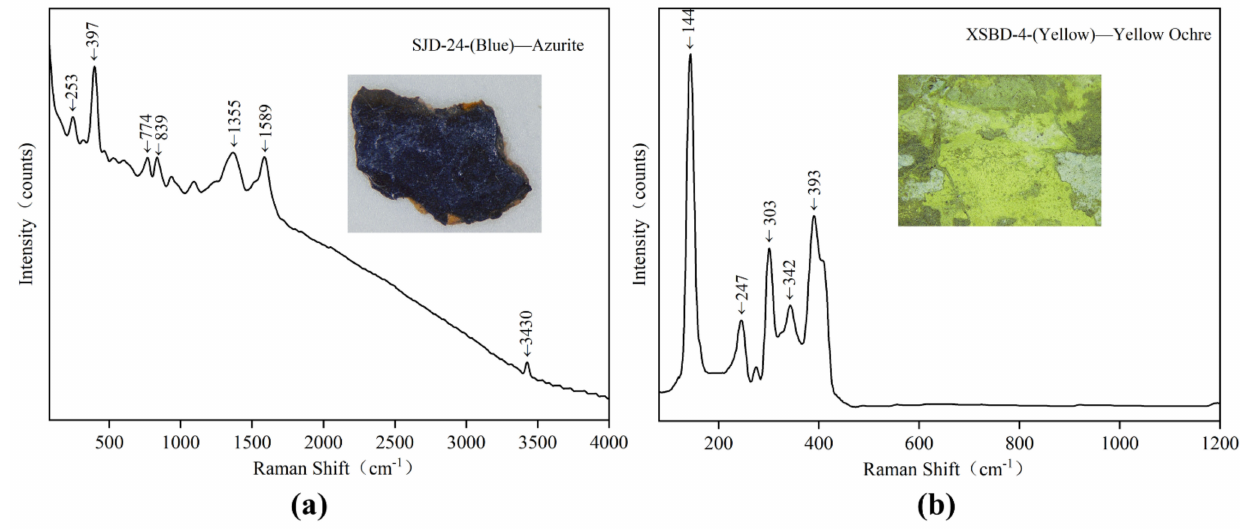
Figure 12. Digital microscopy (DM) and Micro-Raman spectroscopy of samples: ( a ) SJD-24 blue pigment; ( b ) XSBD-4 yellow